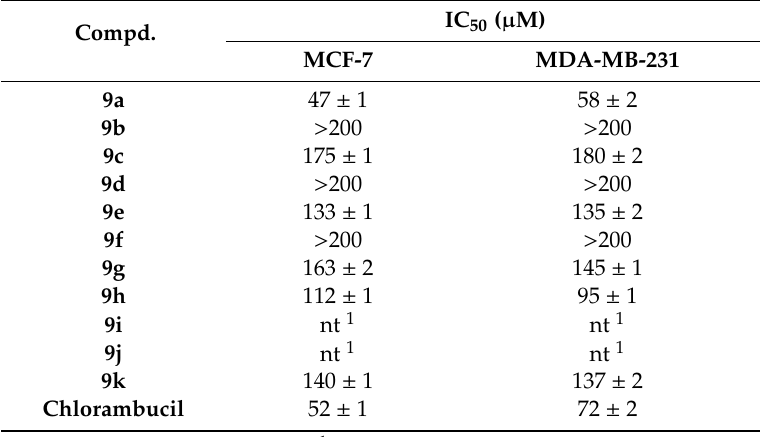
Table 6. Collagen synthesis, measured by 5-[ 3 H]-proline incorporation into proteins susceptible to the action of bacterial collagenase, in MCF-7 and MDA-MB-231 breast cancer cells in the presence of compounds 9a–k and chlorambucil.